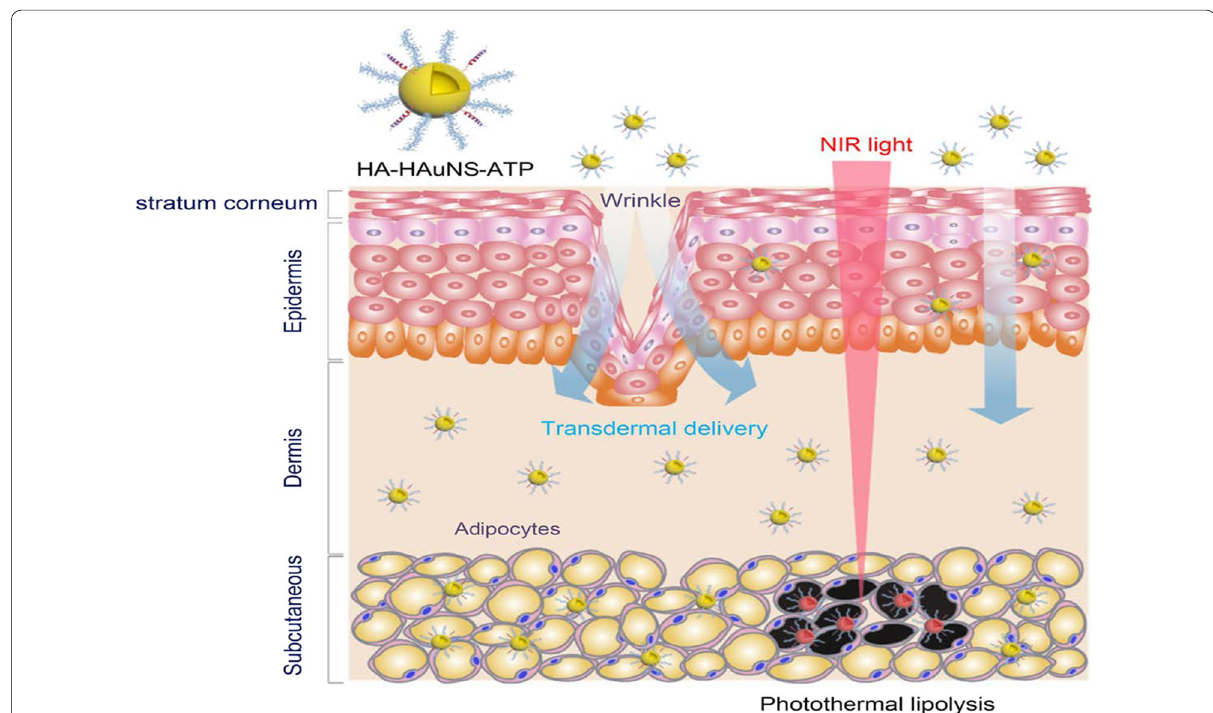
Fig. 10 PT lipolysis of the sWATs using HA-HAuNS-ATP. The ATP was conjugated to the AuNSs for targeted delivery and destruction of the prohibitin-expressing sWATs after NIR laser exposure. Reproduced with permission [52]. Copyright 2017, American Chemical